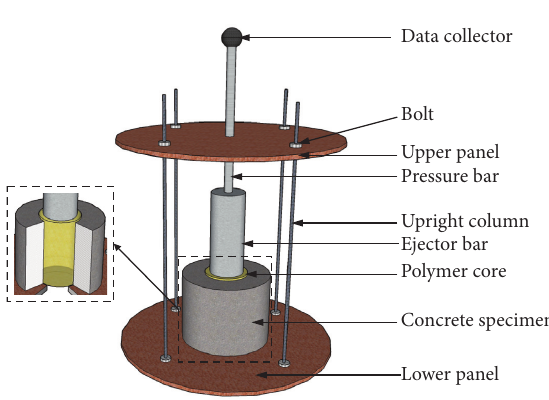
Figure 3: Moisture growth